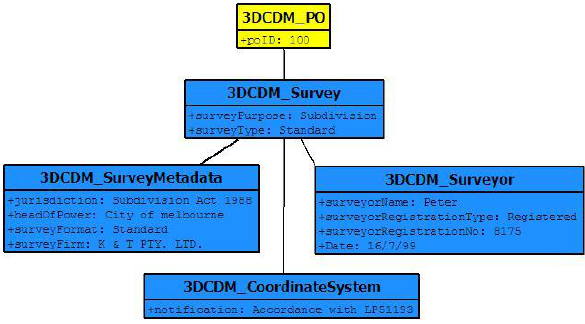
Figure 20. Instance of 3DCDM_Survey